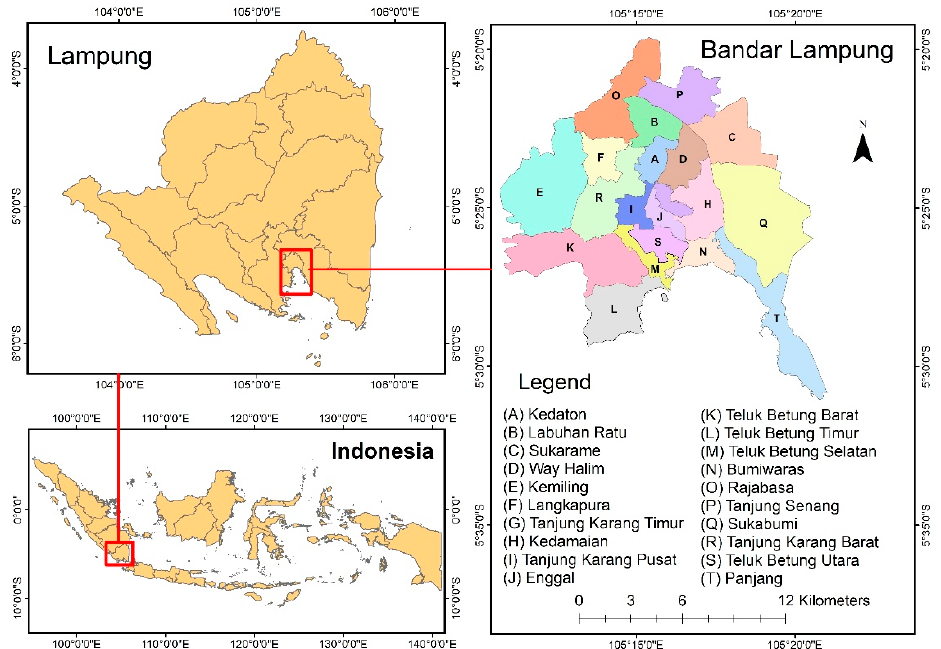
Figure 1. Administration map of Bandar Lampung, Indonesia.